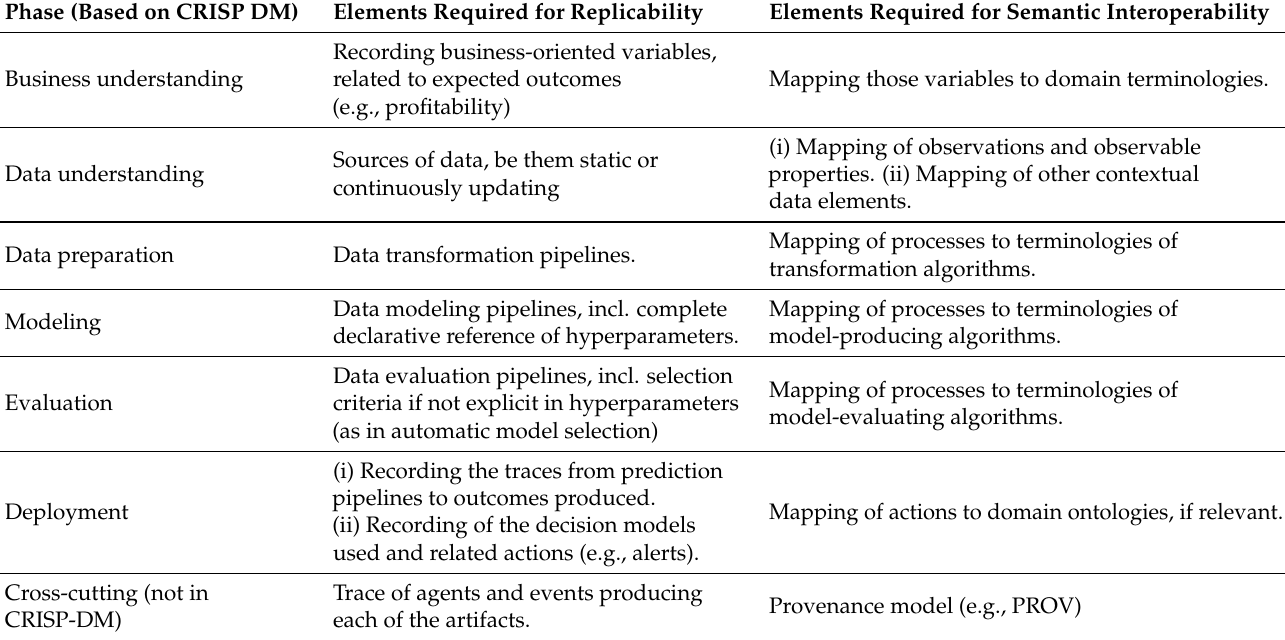
Table 2. Summary of the elements of the minimum description